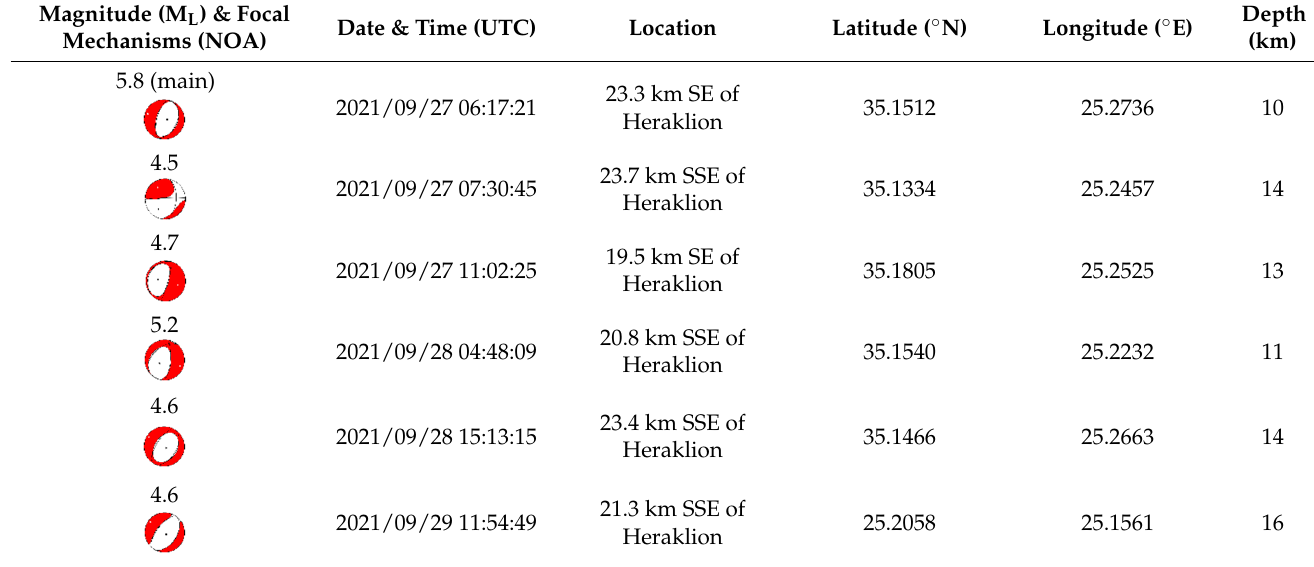
Table 1. Mainshock and aftershock (M > 4.5) focal mechanism of the 2021 Central Crete seismic sequence (National Observatory of Athens—NOA data) immediately following the earthquake.